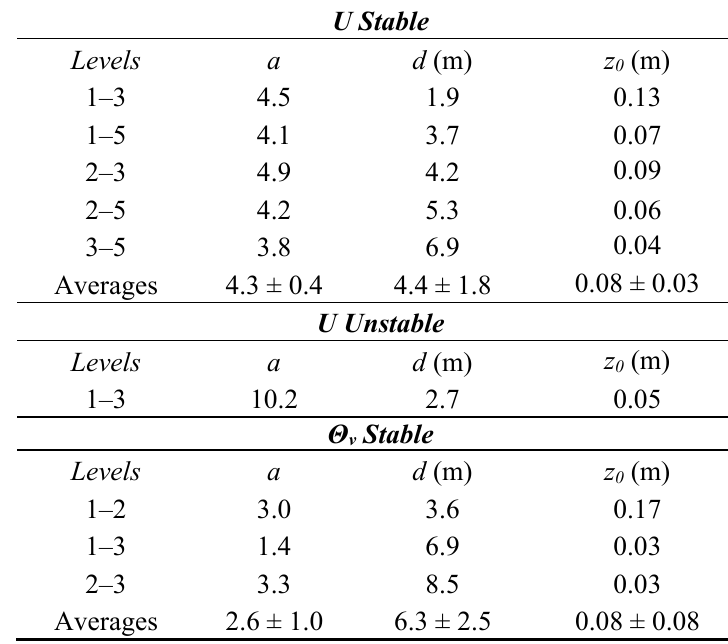
Table 1. a , d and z 0 calculated from the shown couples of levels for U and Θ v (Equations